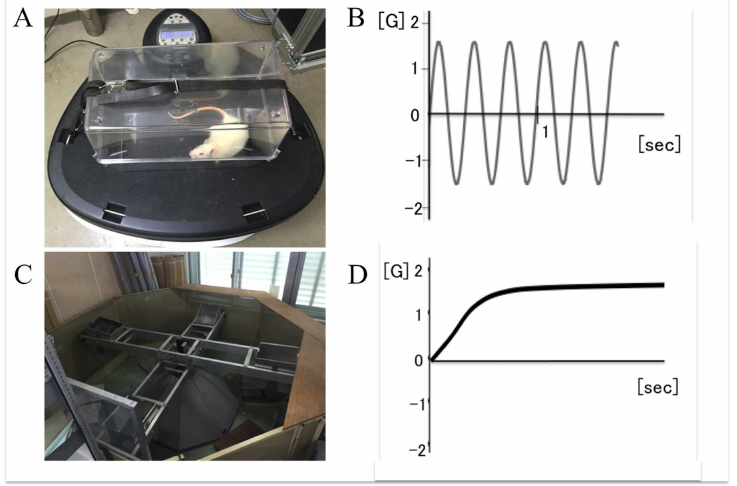
Fig 1. A Power Plate ® Pro5HP ™ (A) and the change (B) of the vibration acceleration intervention and an animal centrifuge (C) and the change (D) of constant centrifugal acceleration